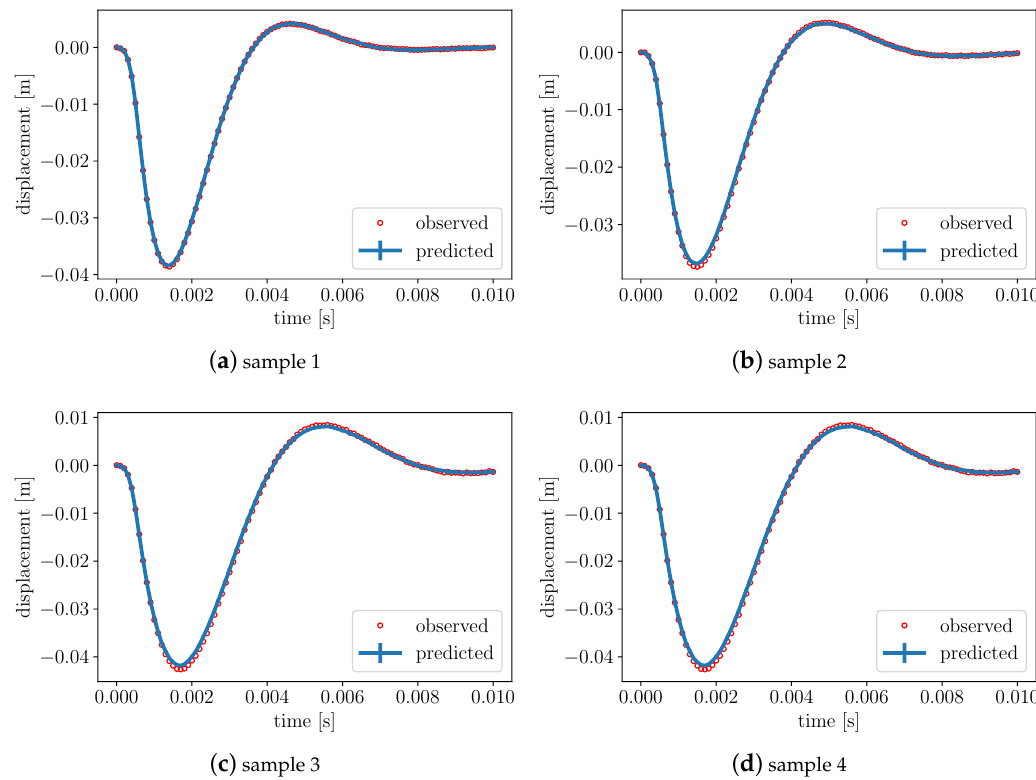
Figure 6. Observed and predicted quantity of interest (QoI) for different testing samples. The test samples are not part of the training set. The errorbars are indistinguishable within the scale of the graph.